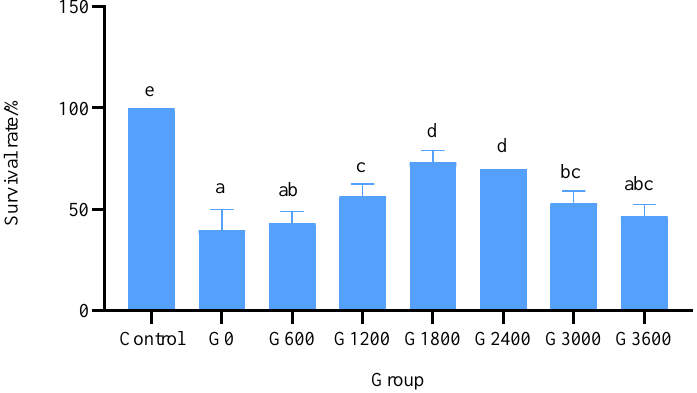
Figure 3. Effects of dietary GML levels on survival rate in bacterial challenge test for juvenile grouper. Data represent means of three tanks in each group; error bar indicates S.D. Values had different letters are significantly different ( p < 0.05).